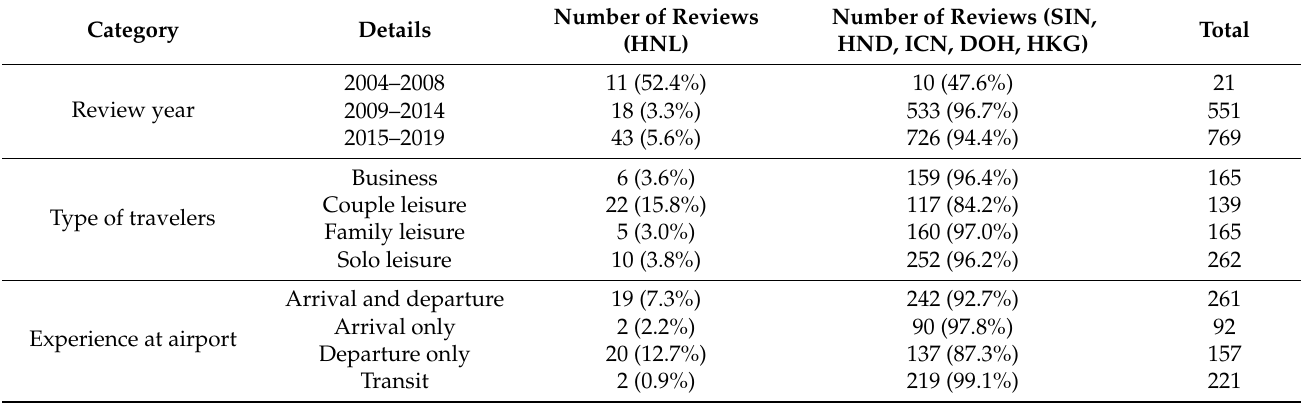
Table 2. Information of the Airport